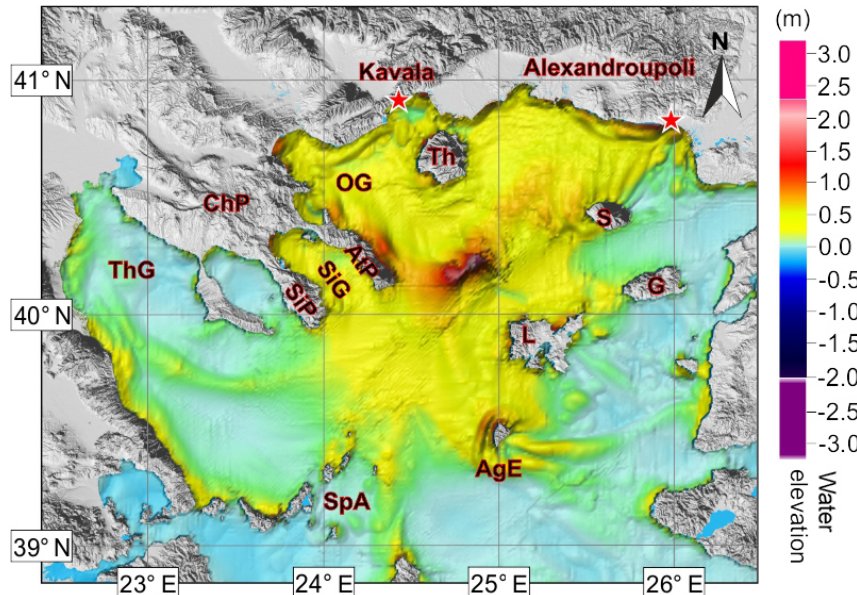
Figure 5. Figure of the maximum water elevation of the tsunami for the first credible scenario (Table 1). AgE is Agios Efstratios, AtP is Athos peninsula, G is Gokceada, L is Lemnos, OG is Gulf of Orfani, S is Samothrace, SiG is Sigitikos Gulf, SiP is Sithonia peninsula, SpA is Sporades archipelago, Th is Thasos, ThG is Thermaic